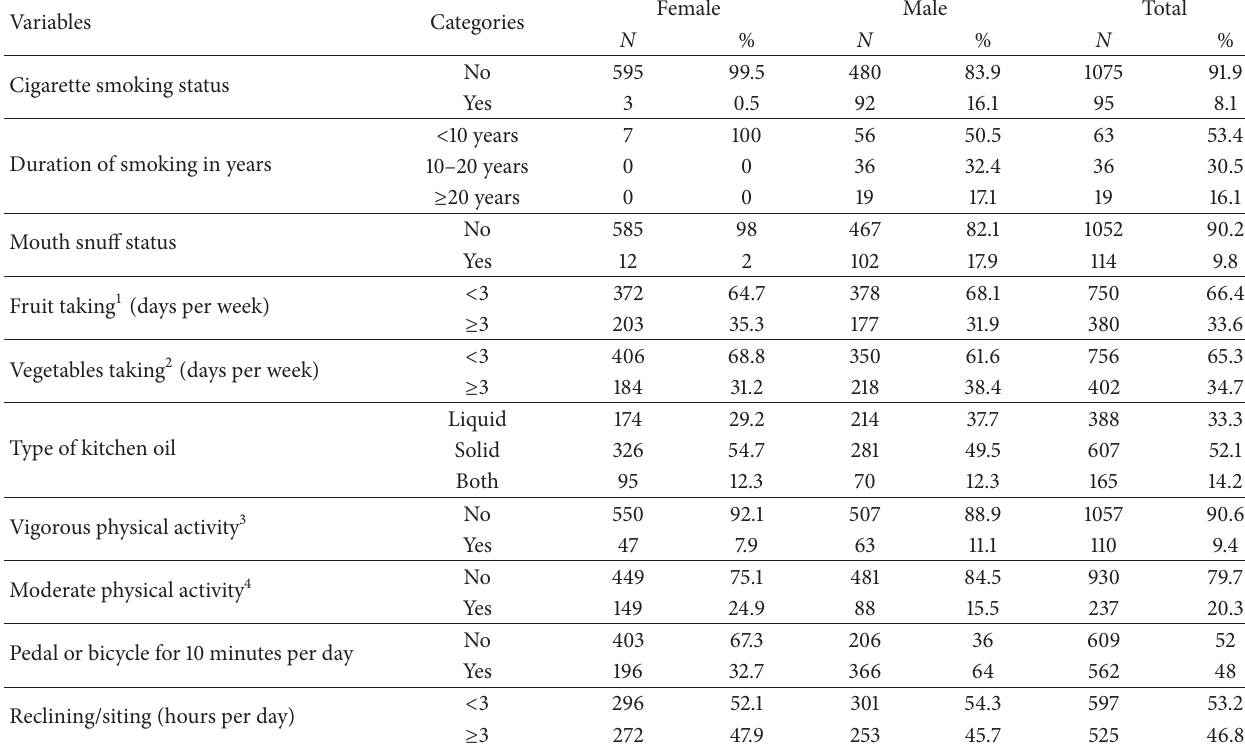
Table 2: Frequency distribution of behavioral risk factors for noncommunicable diseases among the study participants, Kabul city ( 𝑁 = 1172